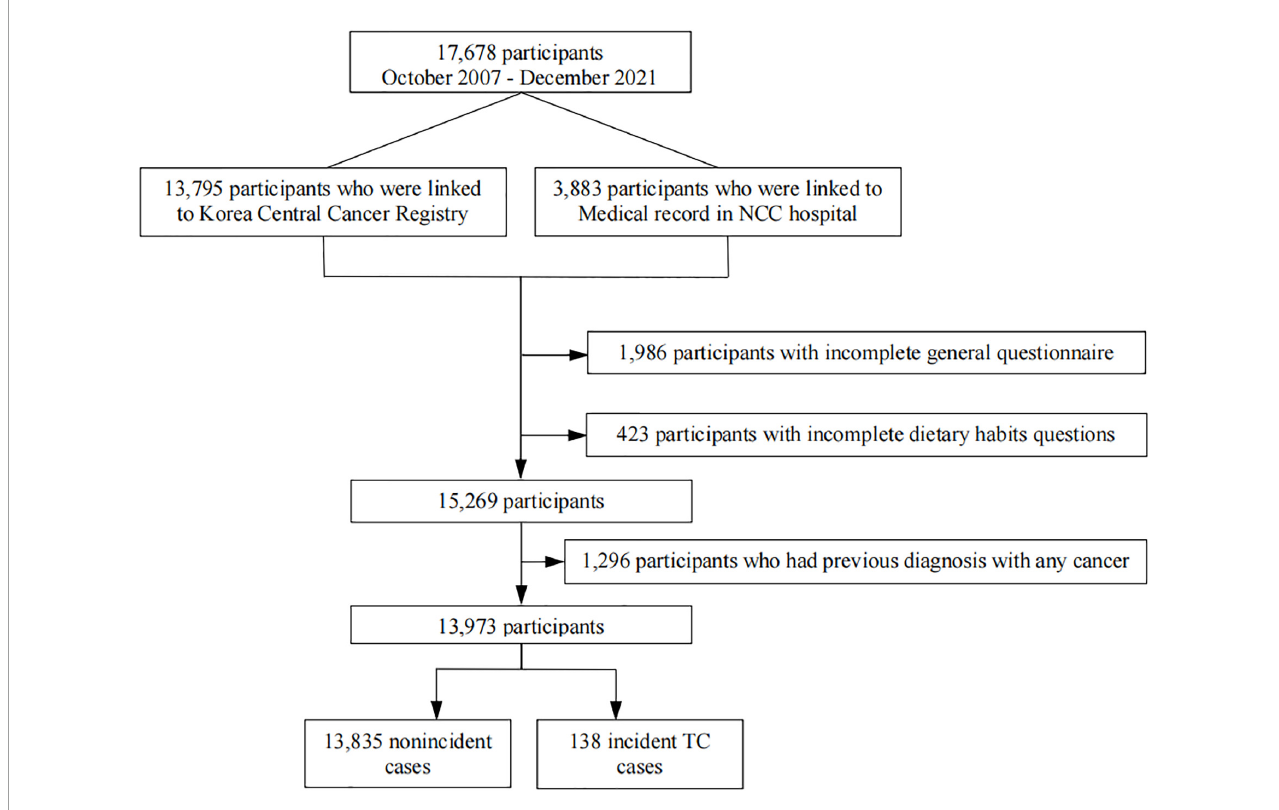
FIGURE1 Flow chart of the study